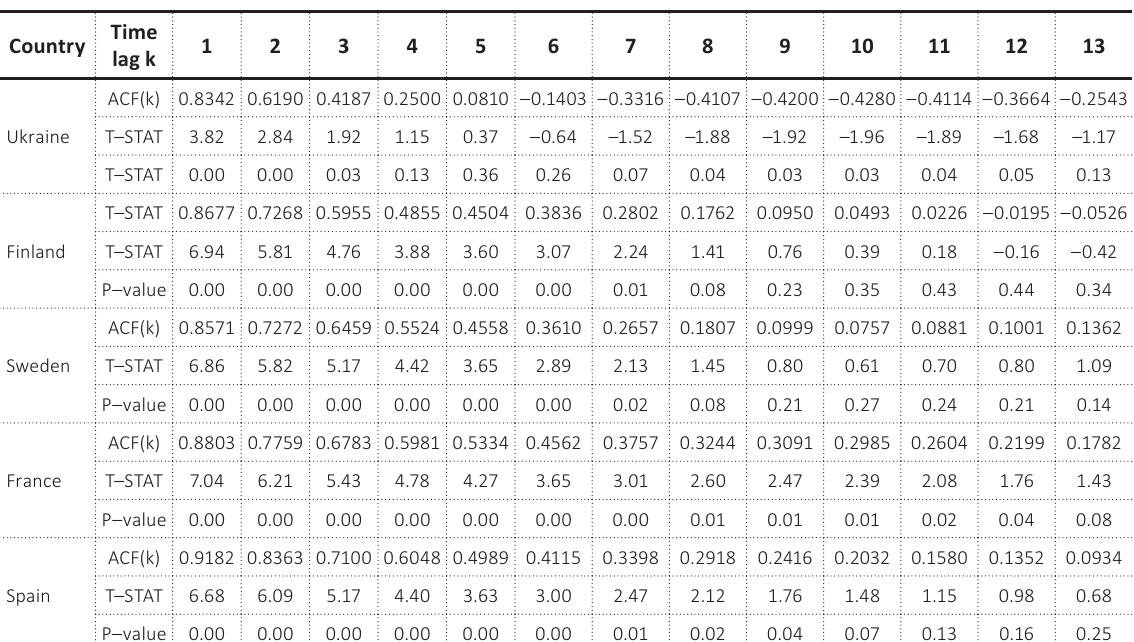
Table C1. Autocorrelation function for the countries’ investment